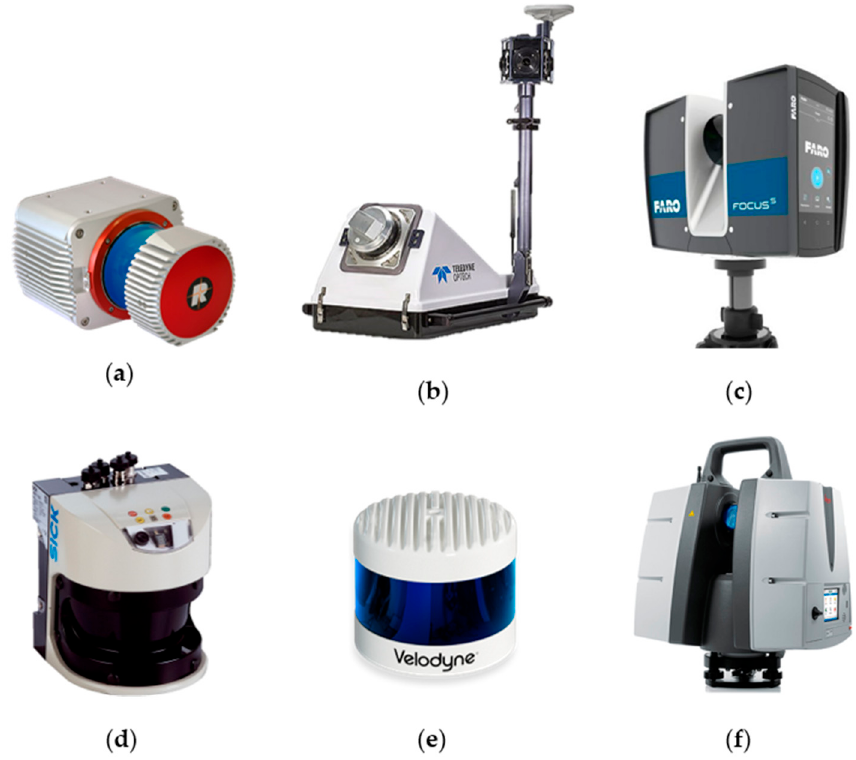
Figure 2. Lidar sensors: ( a ) RIEGL VUX-1HA, ( b ) Teledyne-Optech Lynx HS300, ( c ) FARO Focus 350, ( d ) SICK LMS511, ( e ) Velodyne Alpha Puck and ( f ) Hexagon-Leica ScanStation P50.